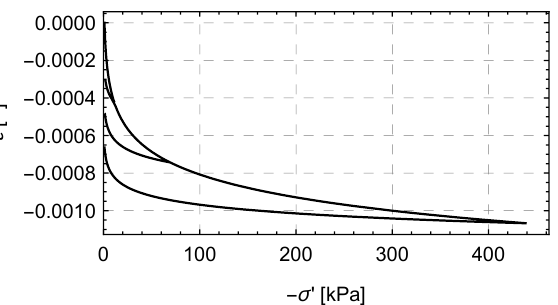
Figure 9. Relationship between σ (cid:48) and strain produced by the model for η =